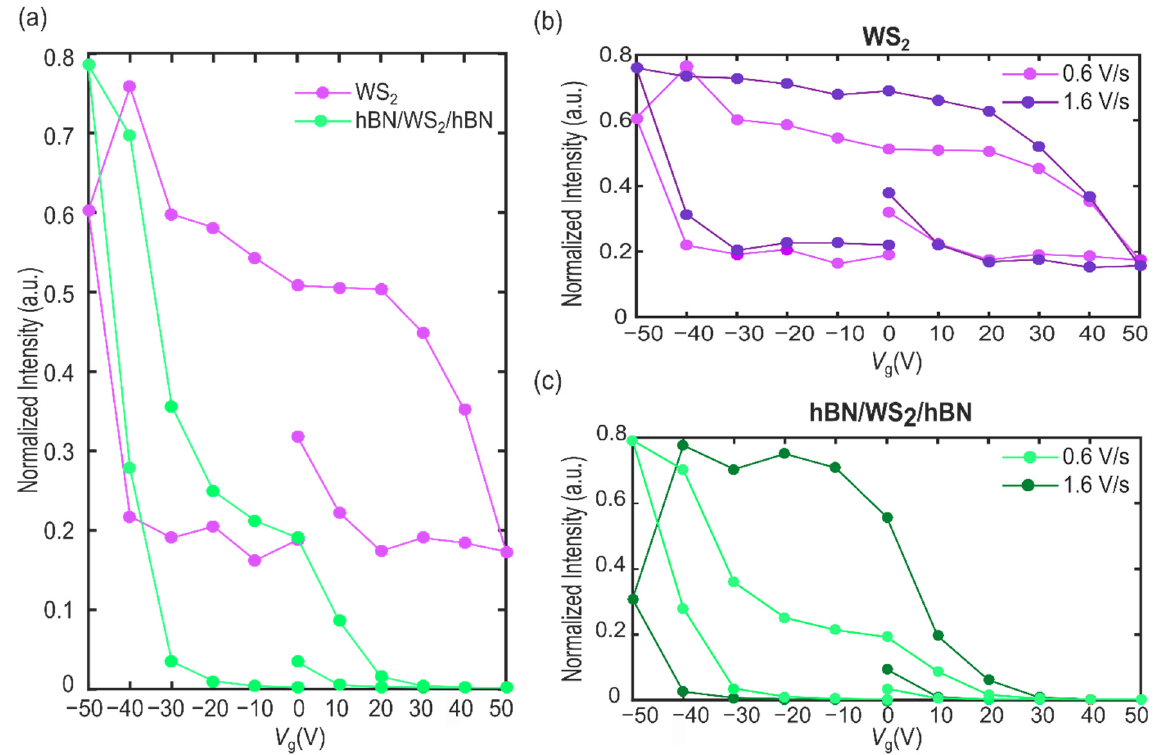
Figure 5. ( a ) Comparison of the gate-dependent optical hysteresis of the X 0 peak integrated intensity in 1L-WS 2 (magenta curve) and hBN/1L-WS 2 /hBN (green curve). ( b , c ) Comparison of the hysteresis with different back-gate voltage sweep rates for the X 0 intensity in 1L-WS 2 ( b ) and in hBN/WS 2 /hBN ( c ) at 0.6 V/s and at 1.6 V/s.